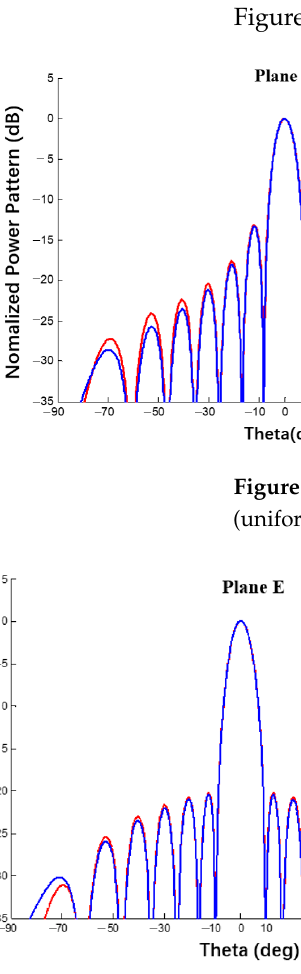
Figure 11. Simulation of 10 × 10 array antenna contrast pattern using MATLAB and HFSS (Dolph– Chebyshev excitation).